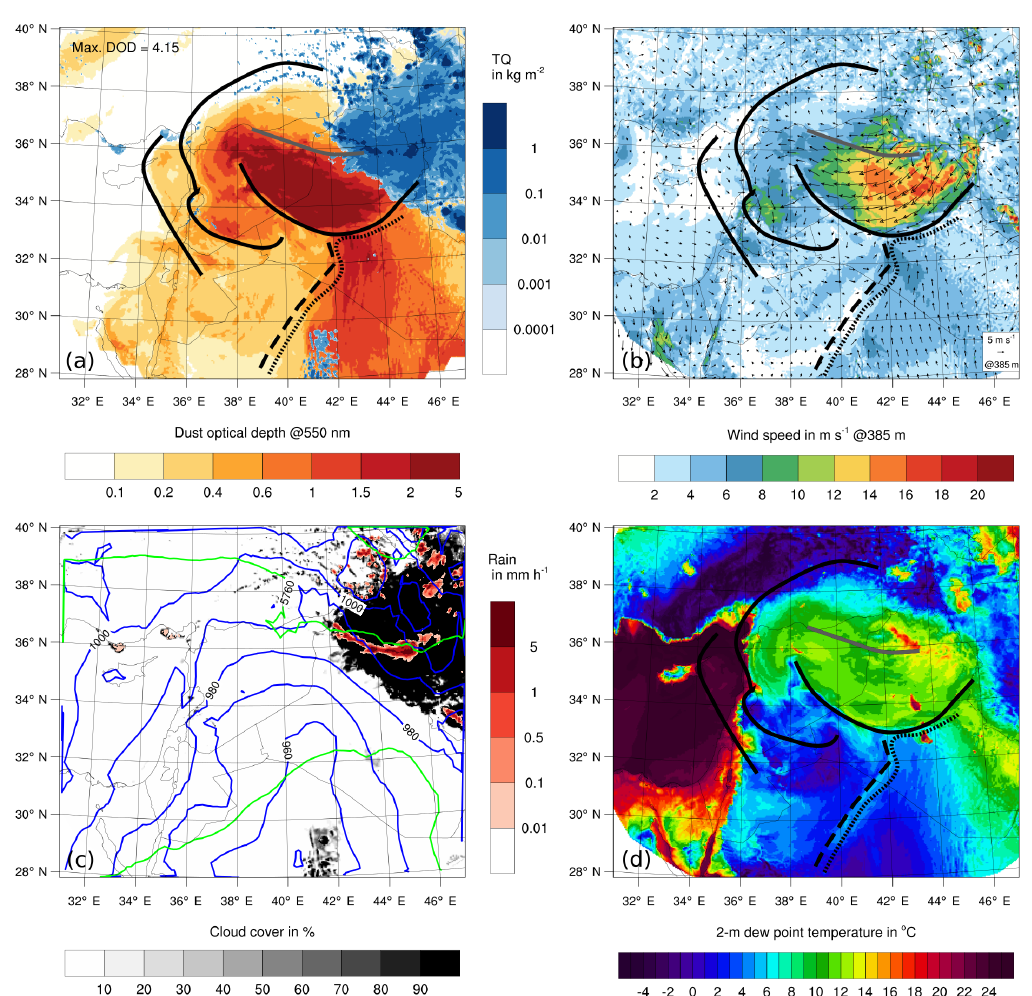
Figure 5. ICON-ART model results at 10:00UTC, 7 September. Displayed are (a) DOD at 550nm overlaid with column-integrated hydrom- eteor content (TQ; cloud water, cloud ice and graupel). (b) wind speed at 385m model height and wind velocity as vectors; (c) fractional cloud cover and surface rain rate colour-coded – blue lines show geopotential height of 900hPa level at 10gpm intervals, green lines show geopotential height of 500hPa level at 20gpm intervals; (d) 2m dew point temperature. From west to east solid black lines mark the leading edges of the CPO1, CPO2 and the southern CPO3 boundary. The grey line marks the northern dust plume boundary inside the CPO3. The dashed line marks merged EM inflow front from 5 and 6 September. The dotted line marks the frontal region of inflow from the Persian